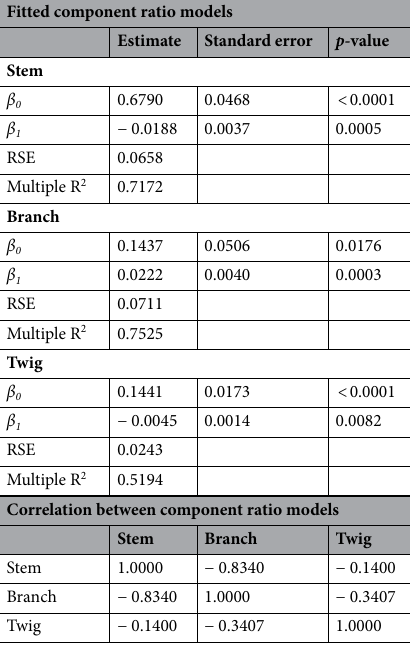
Table 3. Estimated parameters and properties of the final fitted linear seemingly unrelated regression models (Eq. 2) . The estimated parameters are reported for the main stem, large branch, and twig biomass component ratios. RSE is residual standard error.